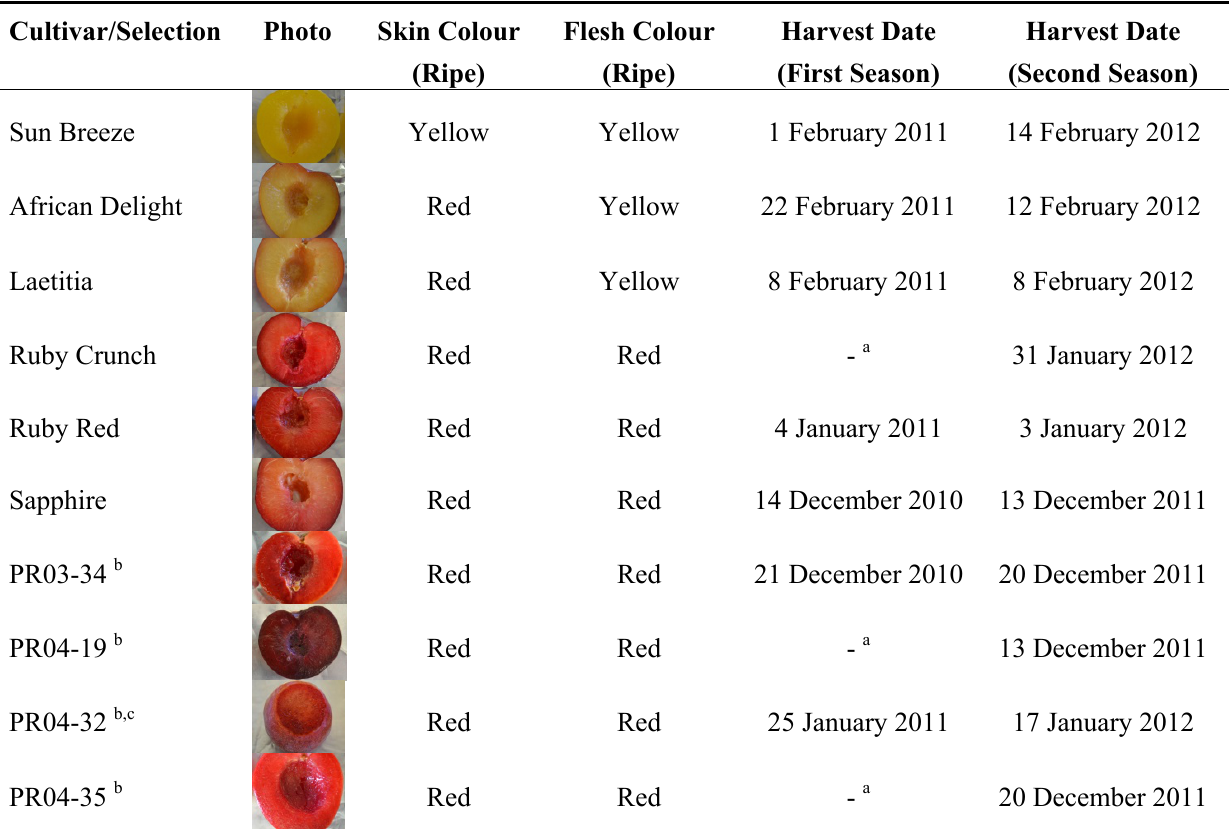
Table 1. Skin and flesh colour and harvest dates of South African plum ( Prunus salicina Lindl.) cultivars and